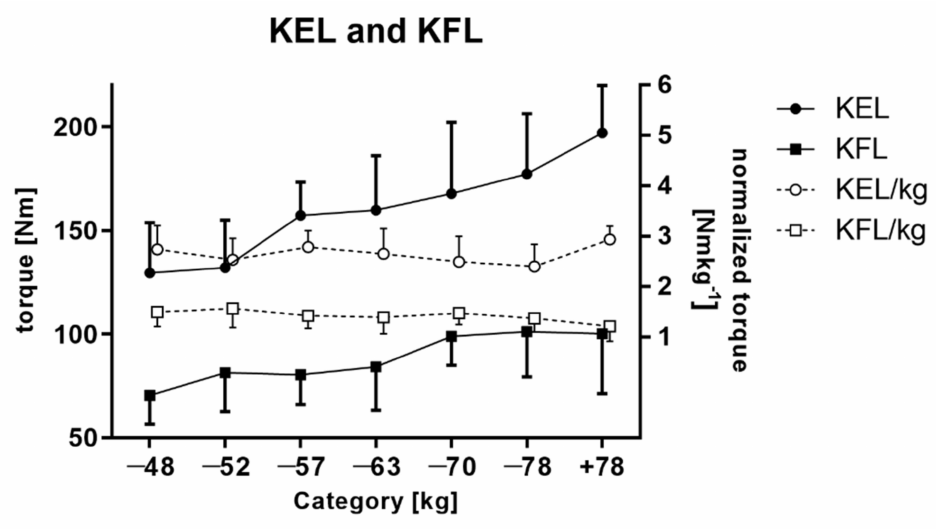
Figure 2. Mean torque and normalized torque values of extensors and flexors of the left knee.